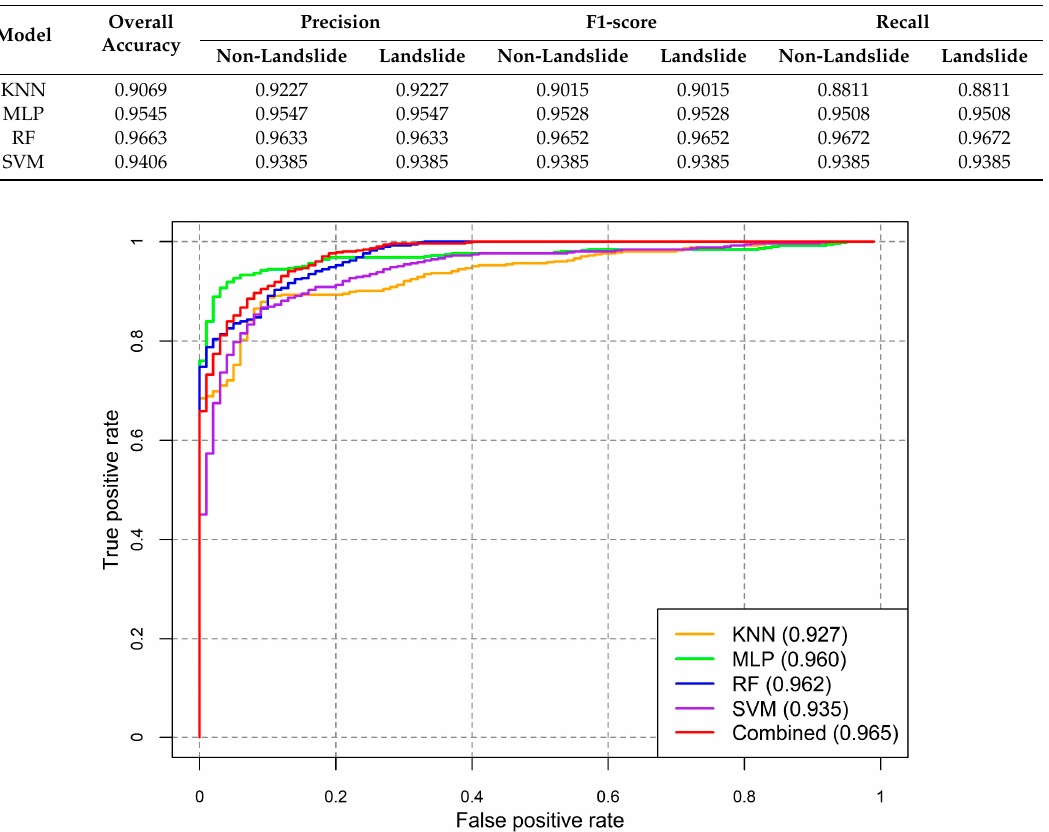
Figure 7. Receiver operating characteristic (ROC) curves of the five models: K-Nearest Neighbor (KNN), Multi-Layer Perceptron (MLP), Random Forest (RF), Support Vector Machine (SVM), and combined model.